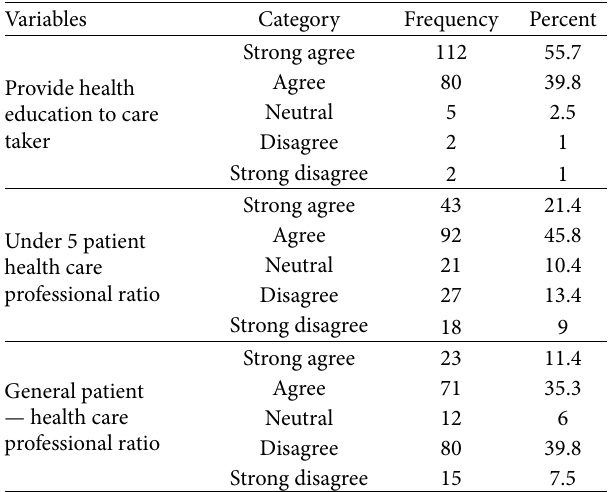
Table 8: The effect of using the IMCI protocol on the patient health care professionals’